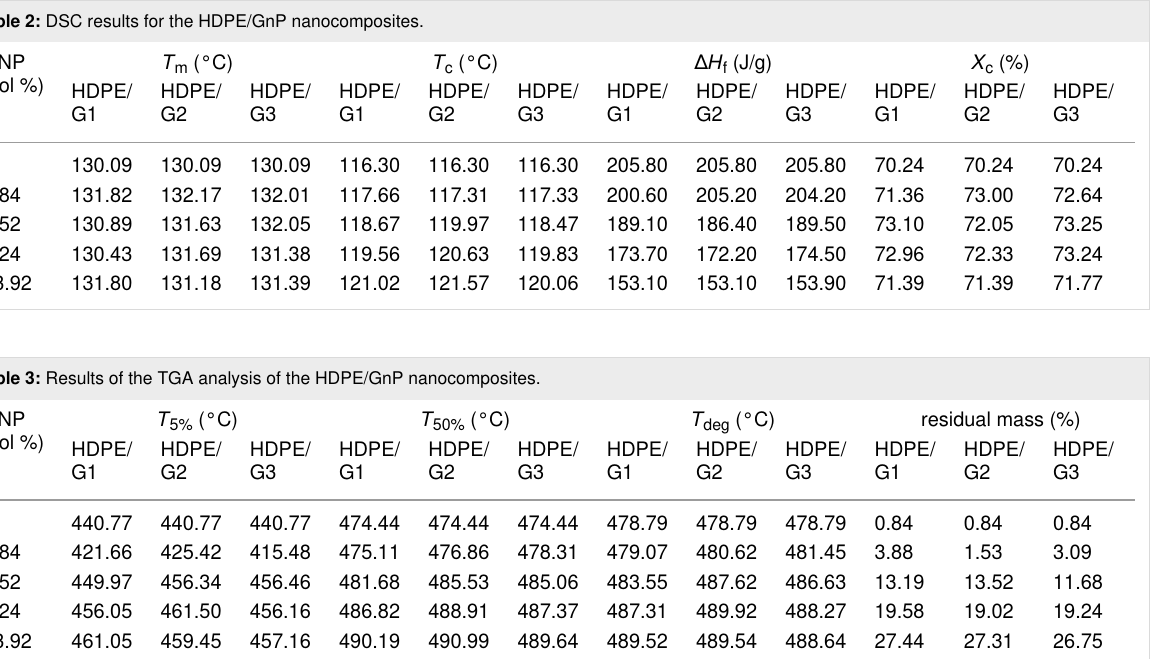
Figure 7. Figure 7 shows that pure HDPE and the three HDPE/ GnP nanocomposites all demonstrated a single-step thermal